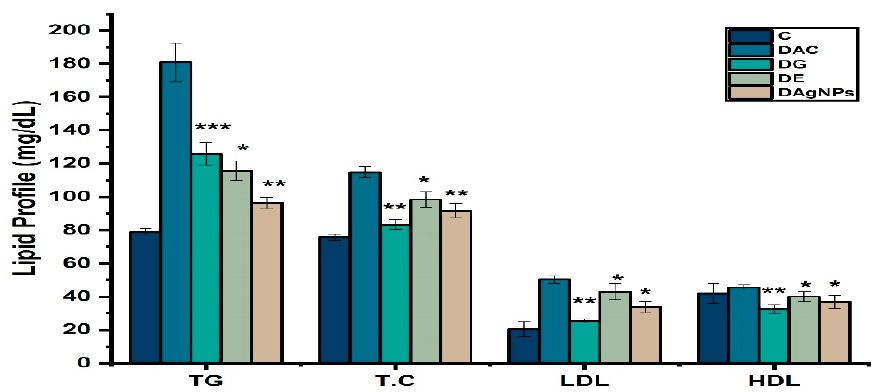
Figure 9. Lipid profile of various treated groups; * p < 0.05; ** p < 0.01; *** p < 0.001 reveals statistically difference between groups.